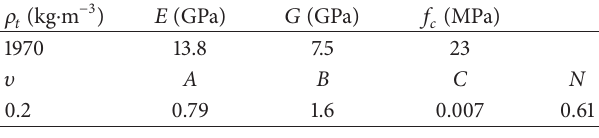
Table 1: Material constants for the HJC model of 23MPa concrete.